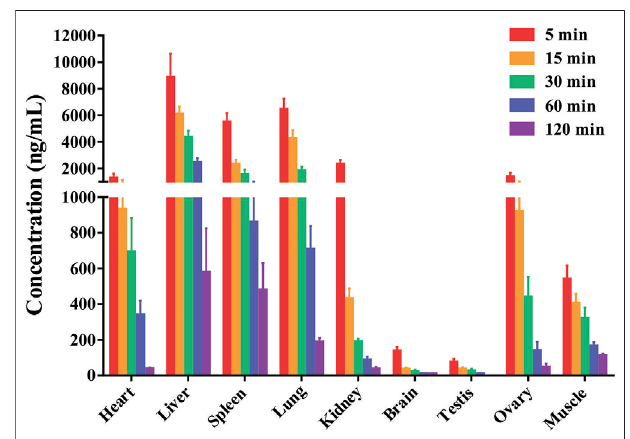
FIGURE 3 | The mean concentrations of DF in the rat tissues were measured at 0.083, 0.25, 0.5, 1 and 2 h after rats received a single intravenous dose of the compound at 4 mg/kg (Mean ± SD, n (cid:1) 6), DF primarily accumulated in the liver, lung, spleen and